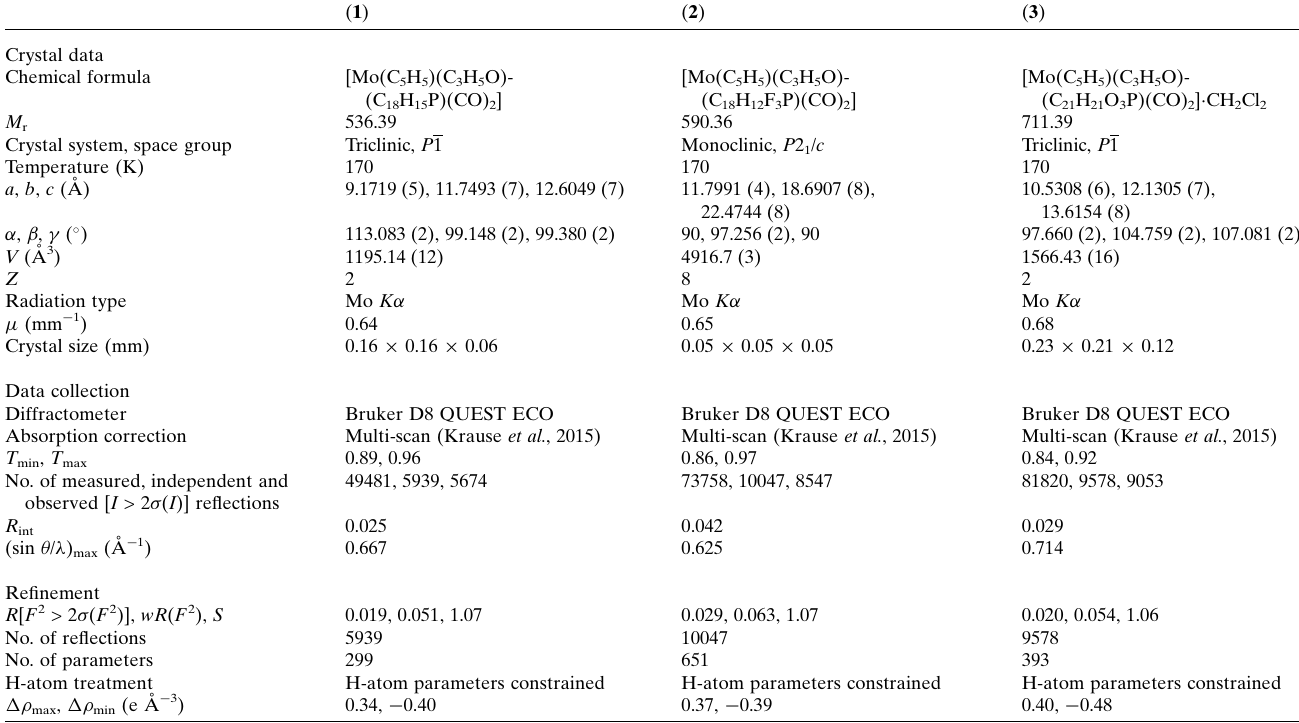
Table 7 Experimental details.